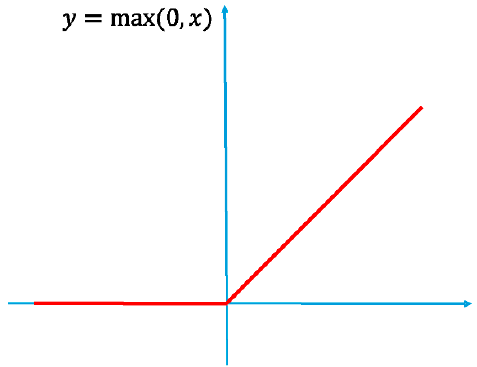
Figure 3. The ReLU function.